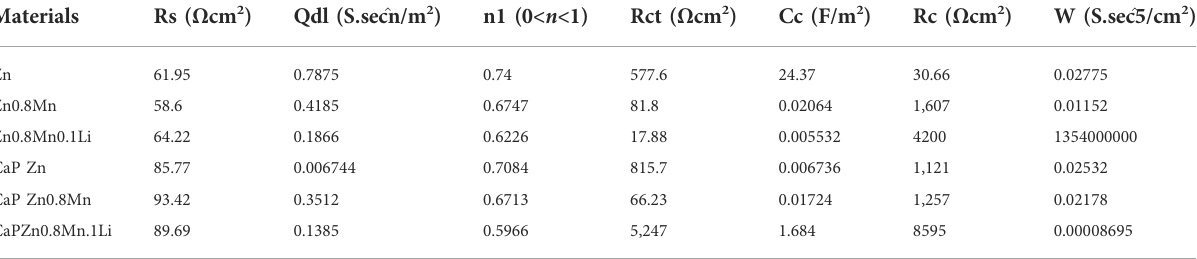
TABLE 4 Fitting parameters in